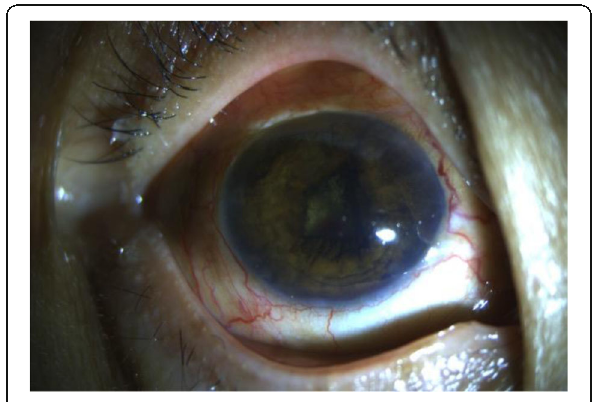
Fig. 8 Anterior segment photography of right eye 3 month after diagnosis